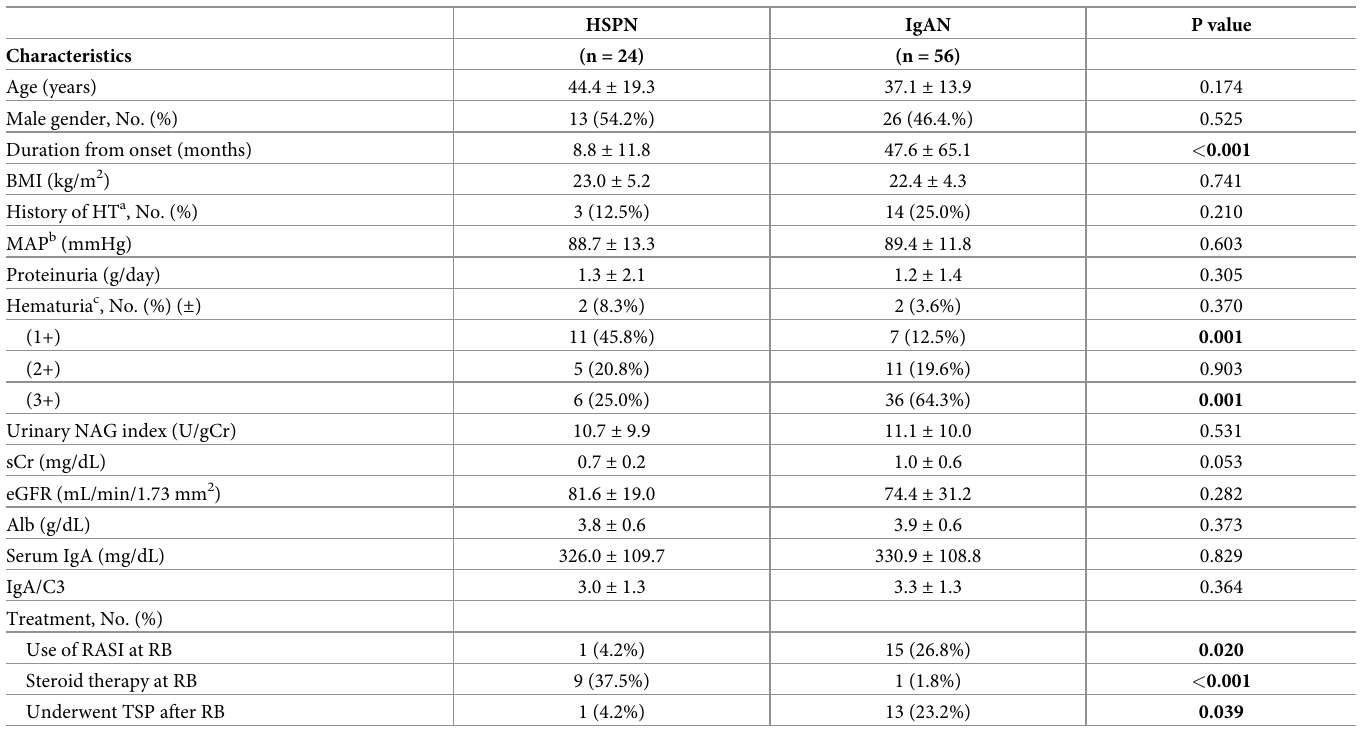
Table 1. Clinical characteristics of patients with HSPN and